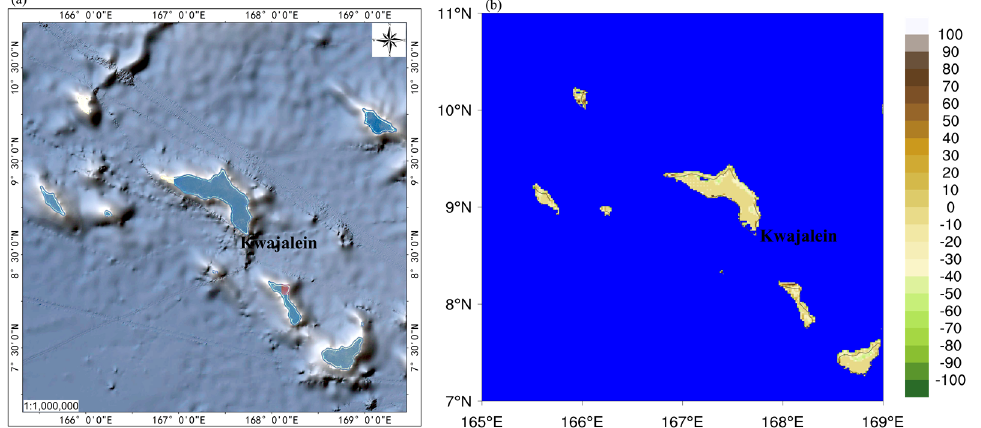
Figure 1. Map of Kwajalein area, which shows the geography of Kwajalein and the neighboring atolls. The left panel ( a ) shows multi − spectral optical remote sensing images with four bands with a spatial resolution of 10 m on 3 and 14 December, provided by Sentinel − 2 satellites. Data can be accessed at https://scihub.copernicus.eu/dhus/#/home on 1 July 2022. The right panel ( b ) shows land/sea distribution around the Kwajalein and neighboring atolls.